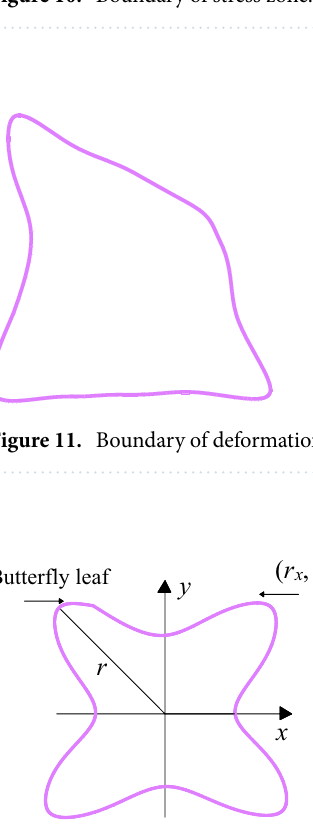
Figure 10. Boundary of stress zone.